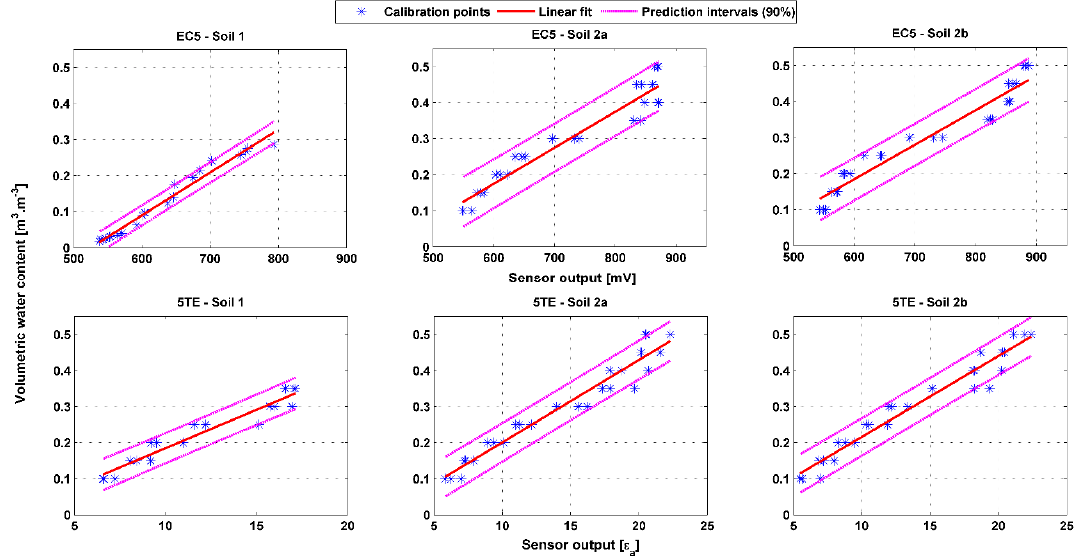
Figure 9. The 90 % predication intervals of the calibration models for sensors EC5 and 5TE in soil 1, 2a and 2b.